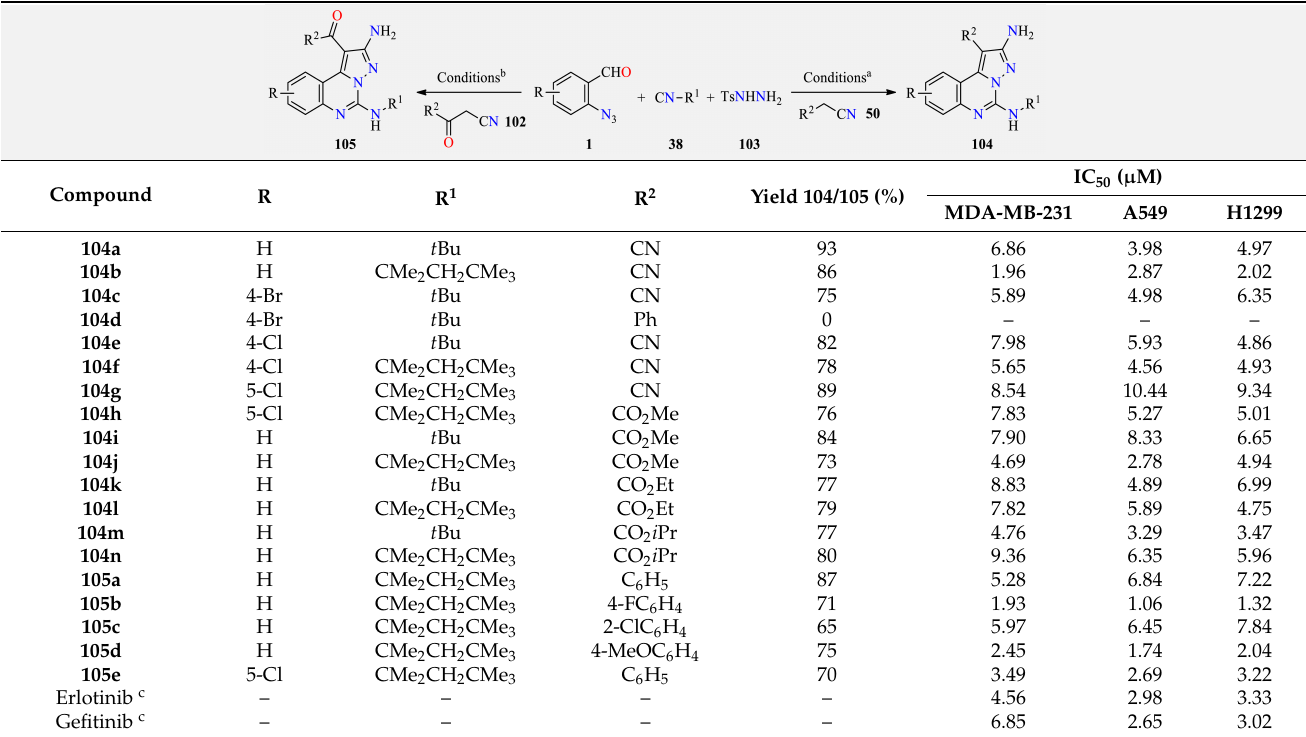
Table 30. Pd-Catalyzed one-pot four-component reaction of pyrazolo[1,5- c ]quinazolines 104 and 105 as potential EGFR